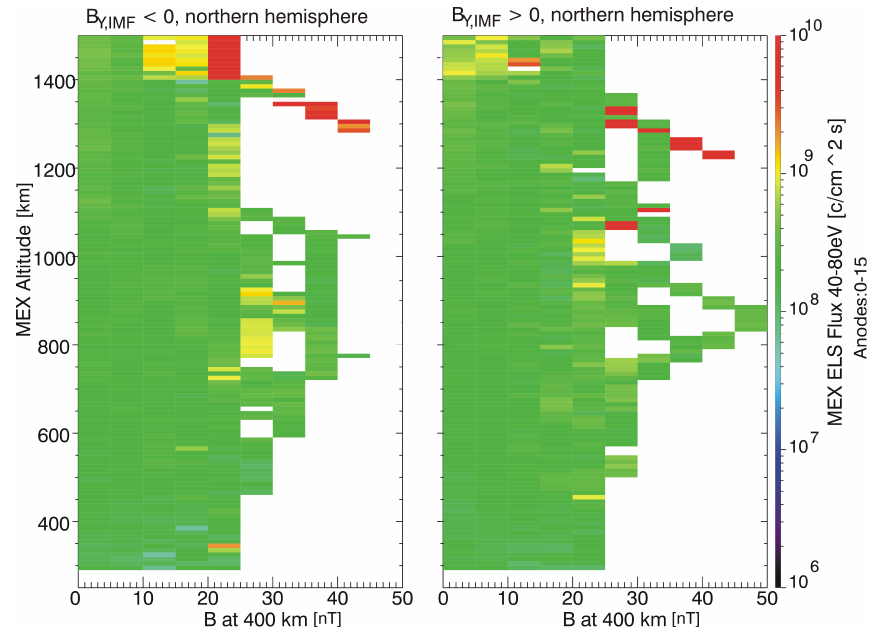
Fig. 8. Total median flux of electrons (40ev <E e < 80eV) on the nightside of the Northern Hemisphere as a function of the crustal field strength and altitude for B y IMF > 0 and B y IMF < 0.